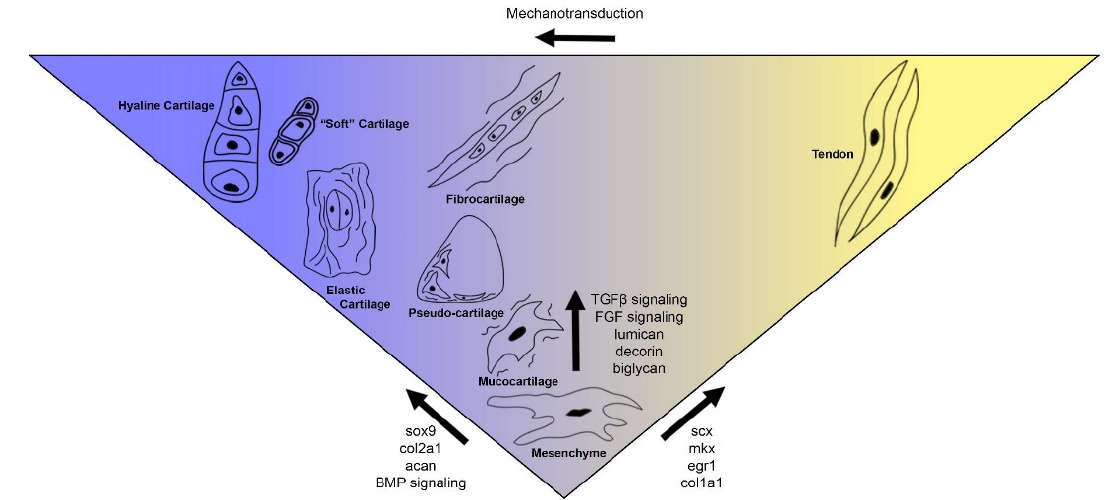
Figure 7. Proposed spectrum of vertebrate cartilage types and their relatedness with one another as well as cell types like tendon. From a common mesenchymal precursor, cells receive continuous input from chondrogenic genes like sox9 or tenogenic genes like scx or mkx and are driven towards an archetypal cell fate. These fates share expression of SLRP genes like lumican , biglycan , and decorin , and are also similarly affected by TGF β and FGF signaling. Even after cells begin displaying tendon-like features, they may transdifferentiate to a cartilage-like fate through mechanotransduction. As a spectrum, there would be quantifiable differences in gene expression between individual cartilage types, both regulatory transcription factors and signaling ligands and receptors as well as ECM pro- teins.